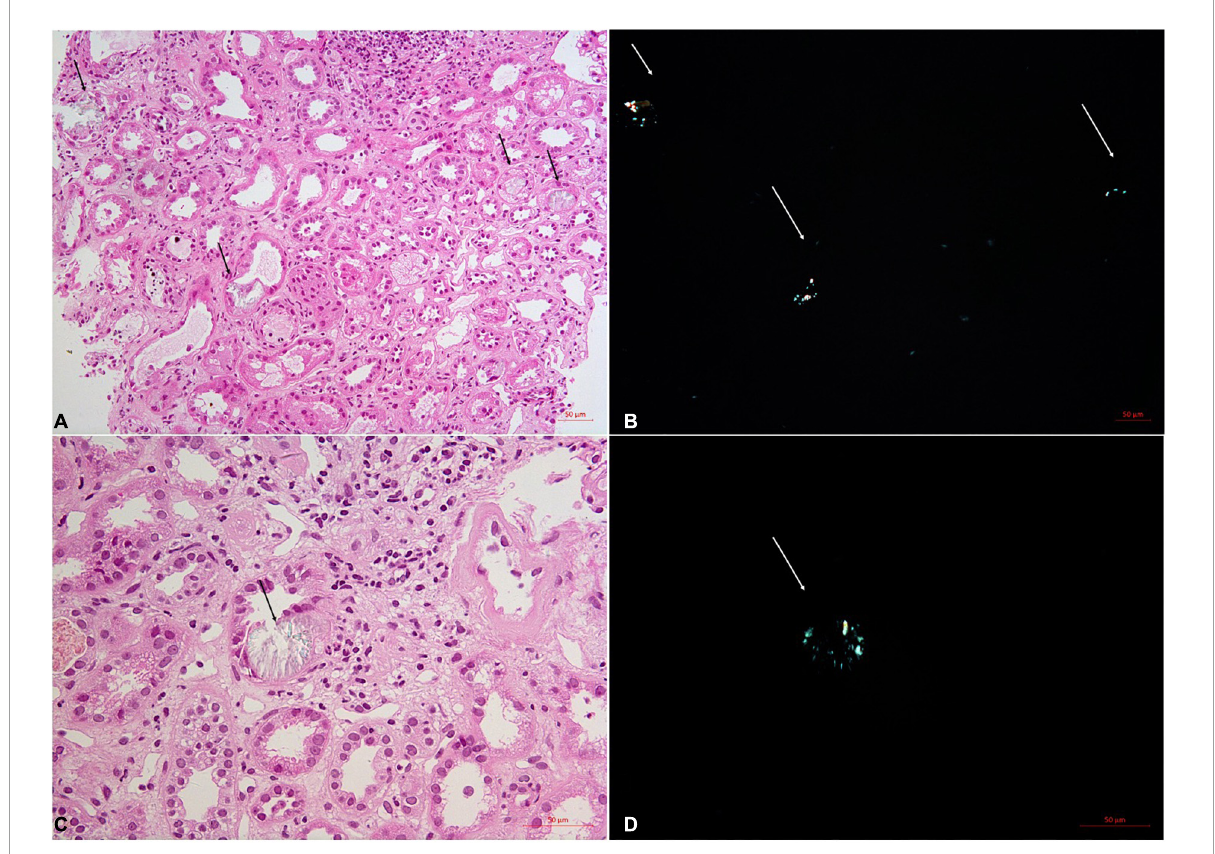
FIGURE1 Renal biopsy of the No. 5 patients with acute oxalate nephropathy. On light microscopy, H&E staining shows acute tubular injuries with numerous intratubular oxalate crystals ( A,C , arrows). These crystals demonstrate birefringence under polarized light ( B,D , arrows). Original magnification 200X (A,B) and 400X (C,D)